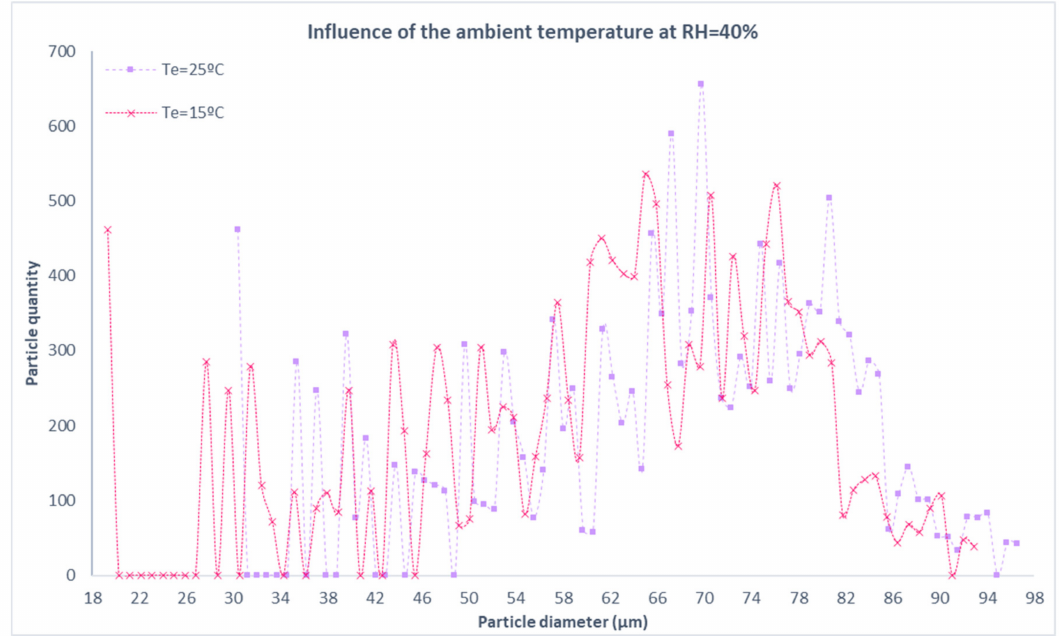
Figure 8. The distribution of the droplets size at t = 2.5 s when the relative humidity was 40%. Comparison between T e = 15 ◦ C and T e = 25 ◦